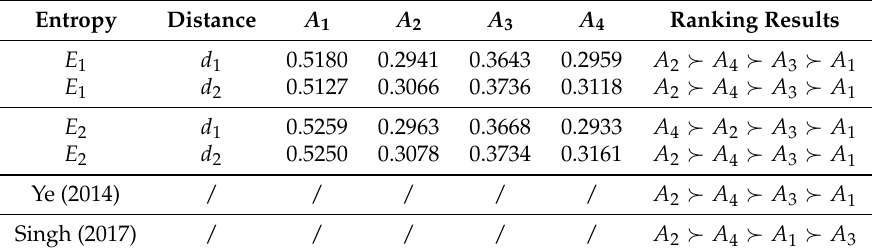
Table 4. Relative closeness RC i ( i = 1,2,3,4 ) and ranking results by three methods.